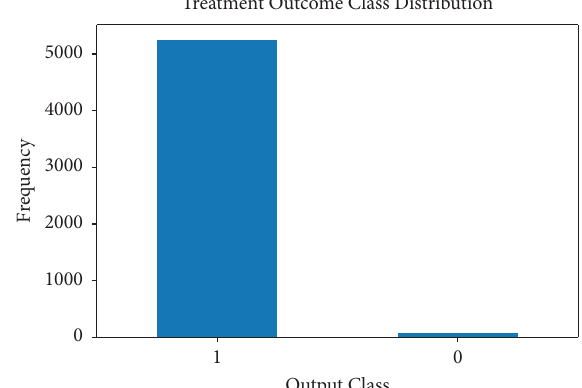
Figure 5: Treatment output class